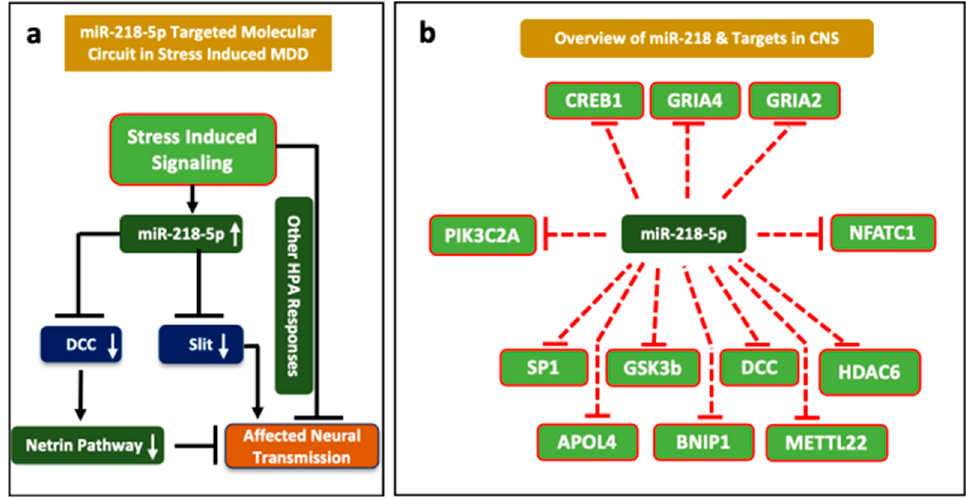
Figure 5. miR-218-5p targeted molecular circuit in stress-induced neuropsychiatric conditions. Stress-induced upregulation of miR-218 causes deficiency in Netrin and Robo signaling pathways via DCC and SLIT genes ( a ). The enriched targets of miR-218 in the central nervous system ( b ).